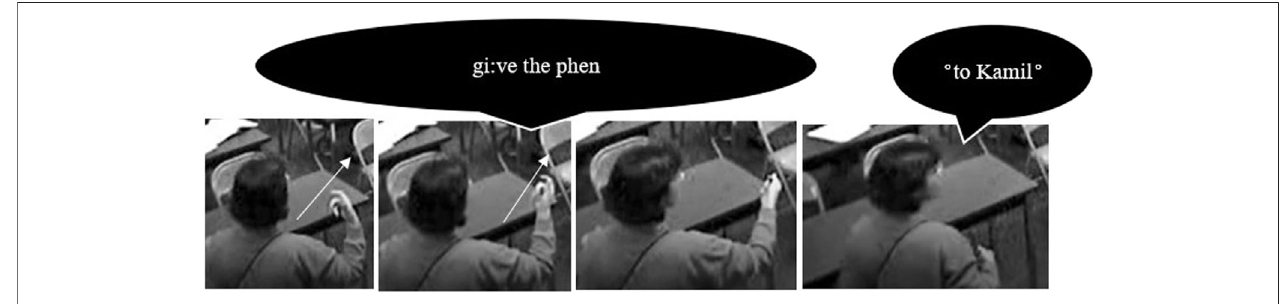
FIGURE 11 | Extract 5. line 4.